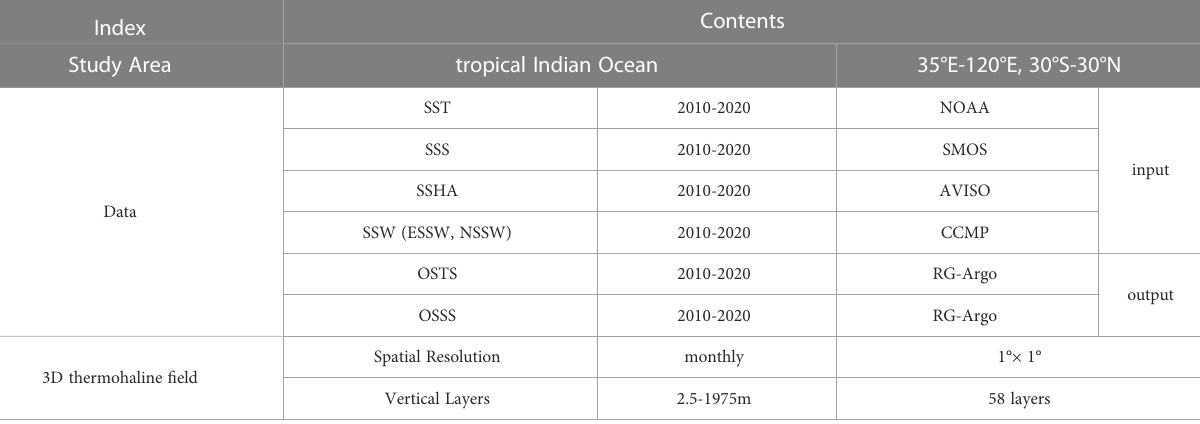
TABLE 1 Summary of data used in this